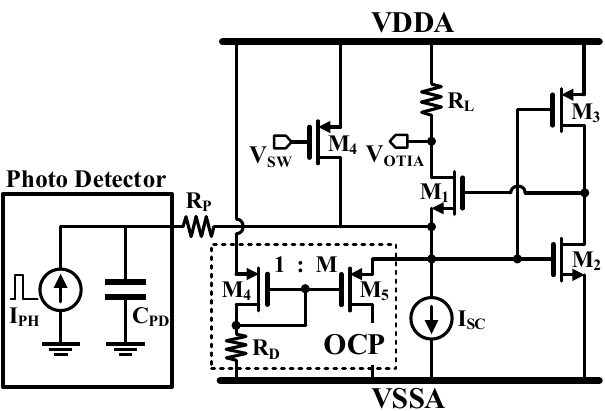
Figure 6. Simplified schematic of a transimpedance amplifier with an over current protector (OCP).